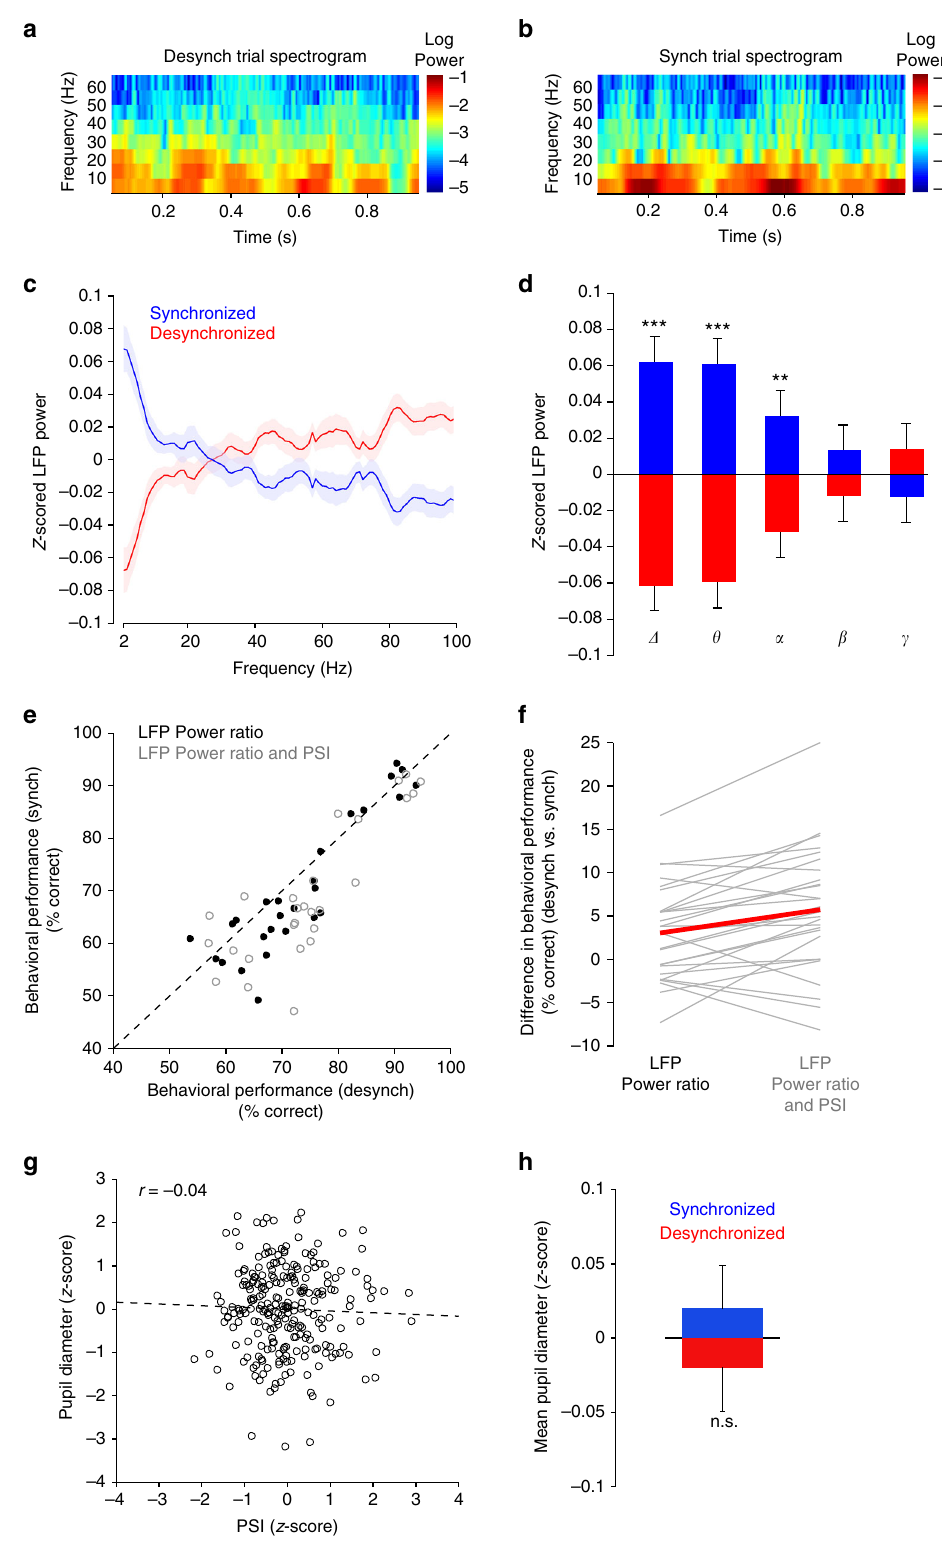
windows ( > 10 ms) yield signi fi cant differences in behavioral performance between the synchronized and desynchronized states (Fig. 3d, P < 0.05, paired t -test, n = 28 sessions); decoder performance difference remained statistically signi fi cant for the 50 ms bin size ( P < 0.001, paired t -test, n = 26 sessions), but not